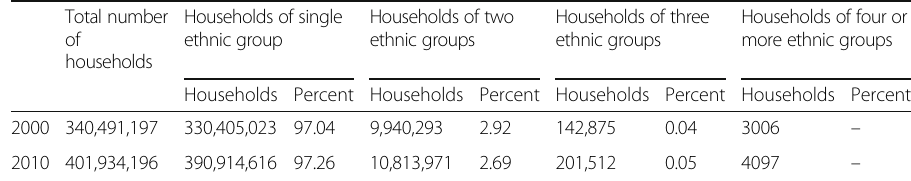
Table 2 Ethnic composition of Chinese households, 2000 and